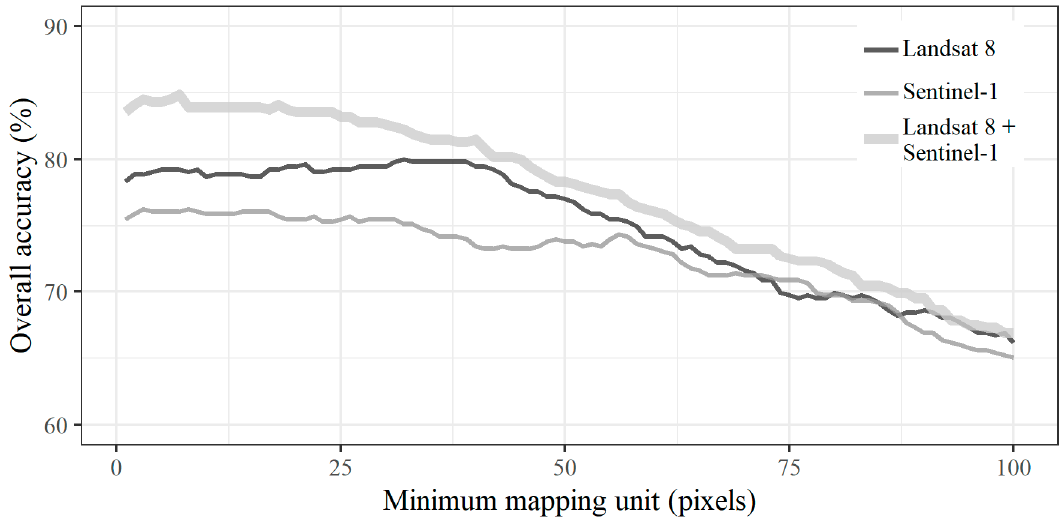
Figure 9. OAs of the detection of disturbance using only Landsat 8, using only Sentinel-1 and combining Landsat 8 and Sentinel-1 for each minimum mapping unit.